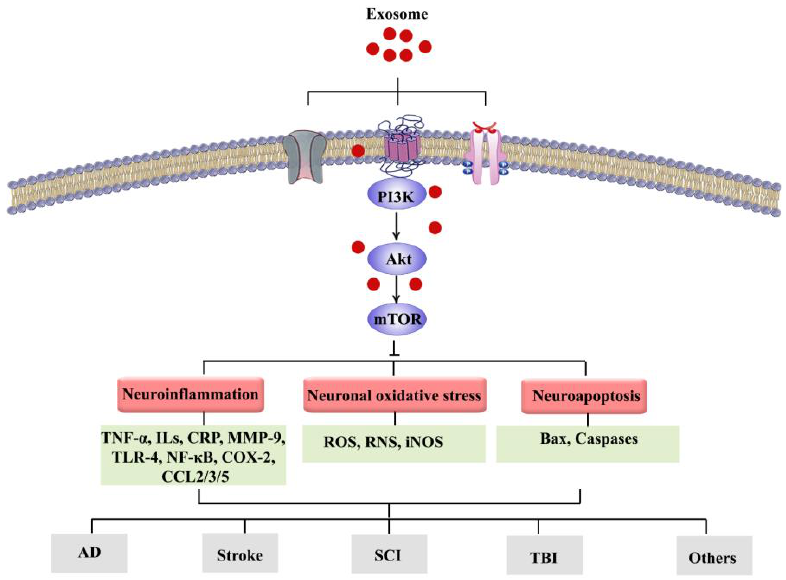
Figure 2. Exosomes can target the PI3K/Akt/mTOR signaling pathway, thereby modulating various interconnected events involved in NDDs towards therapeutic application.